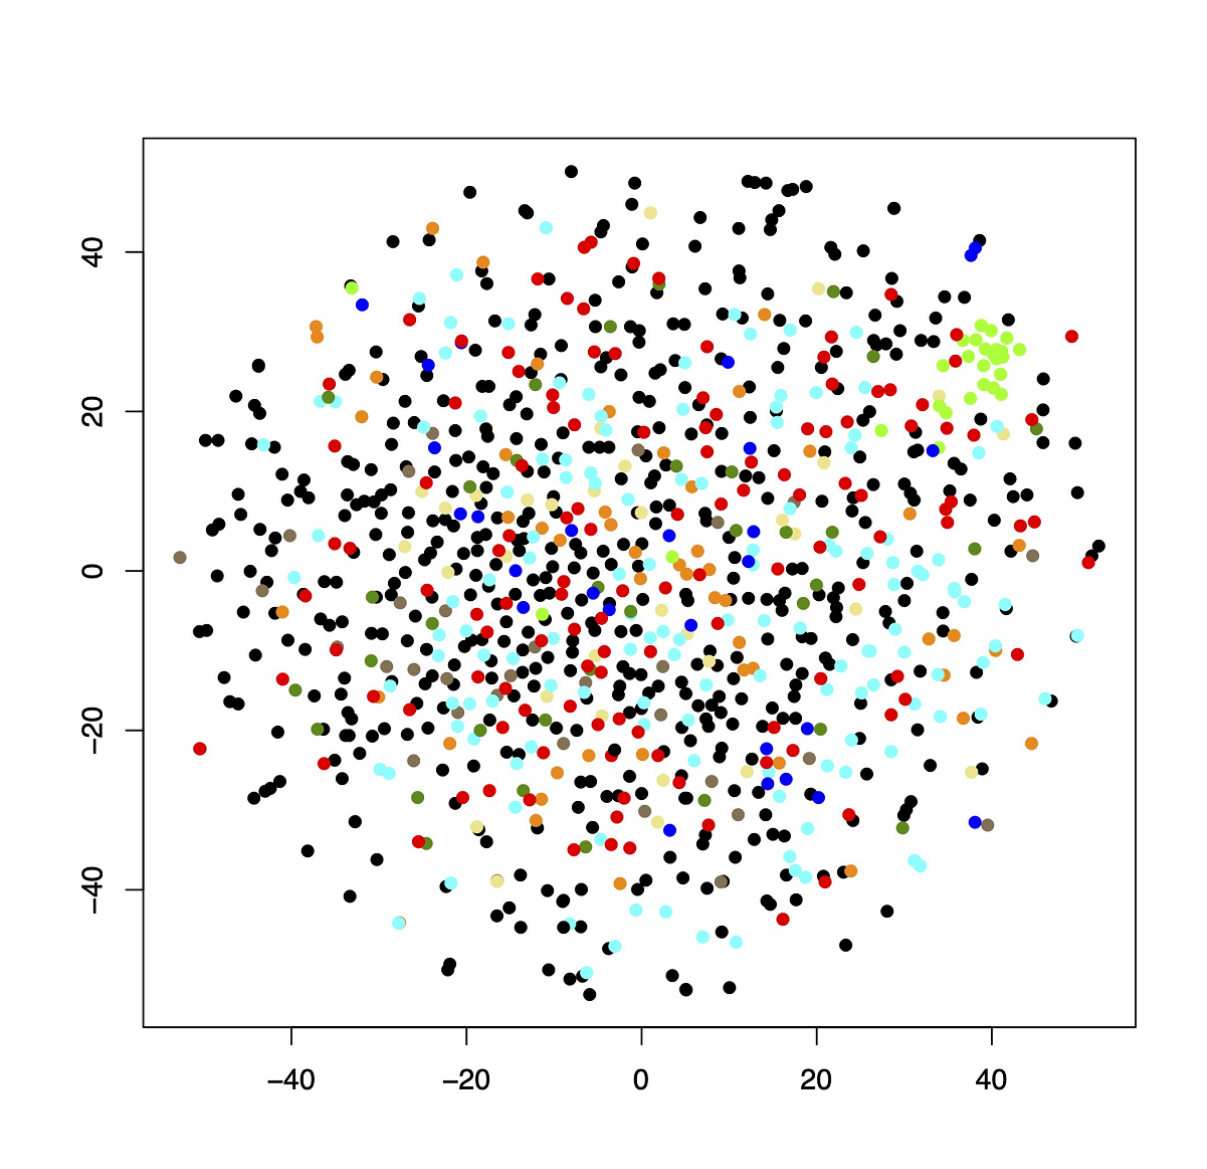
Figure 7. A t-distributed stochastic neighbor embedding plot showing a possible clustering of the 973 test objects concerning the diagnostic system of their disease. Key: black: rare diseases; red: chronic diseases; dark blue: psychiatric diseases with somatoform part; dark green: unknown diagnosis; light green: healthy individuals; light blue: sarcoidosis; orange: idiopathic pulmonary arterial hypertonia; yellow: syringomyelia; brown: systemic lupus